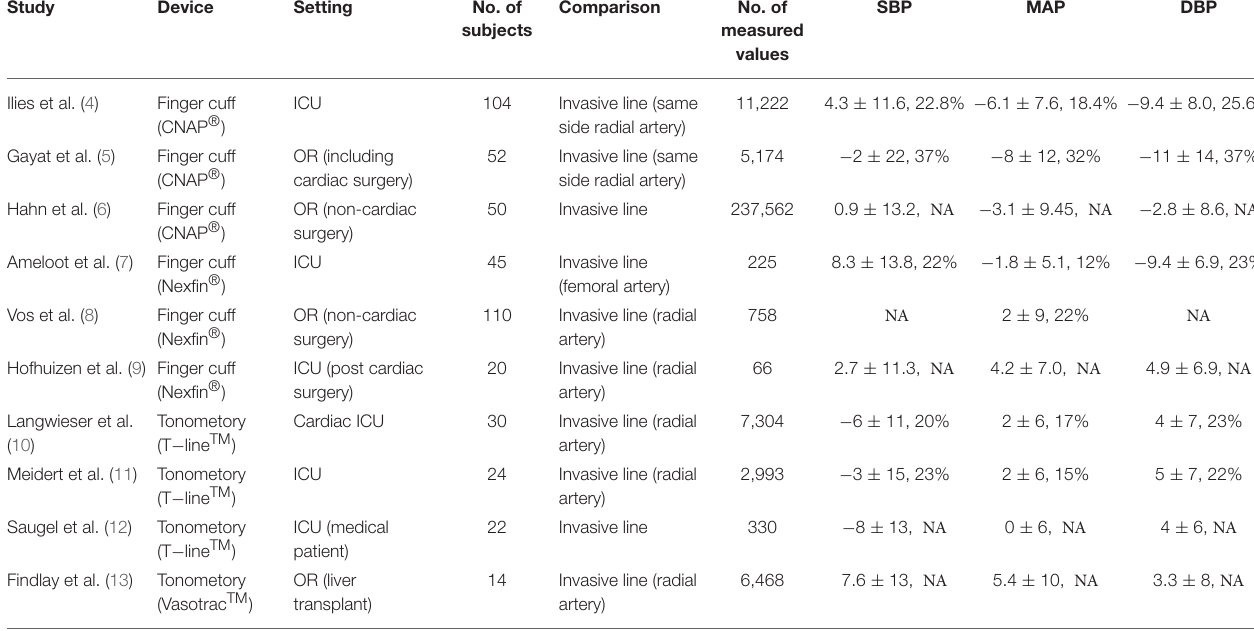
TABLE 1 | Accuracy study of noninvasive continuous blood pressure.